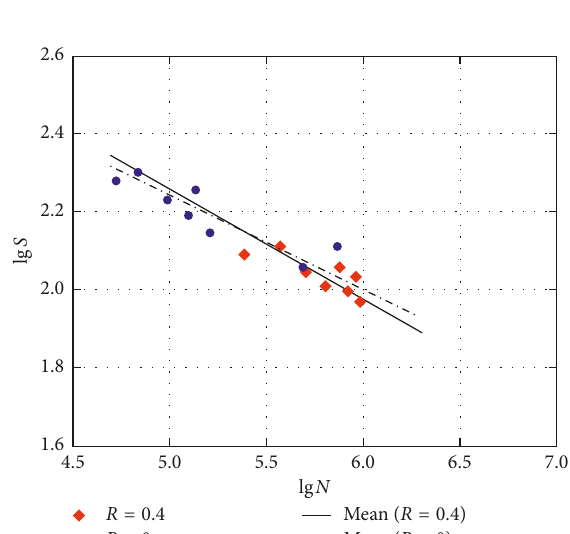
Figure 10: S-N curve.